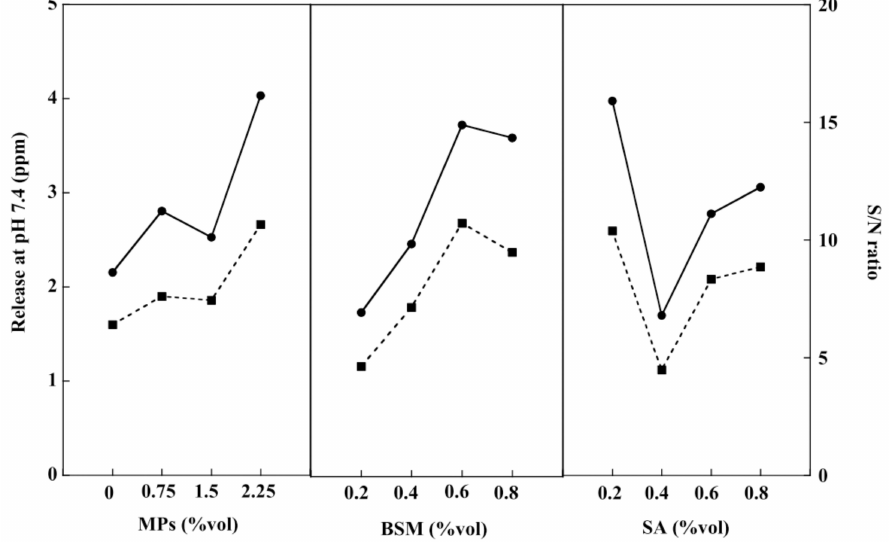
Figure 7. Drug release at pH 7.4 (– • –) and S/N ratio (– (cid:4) –) of the BSM/SA/MPs hydrogel